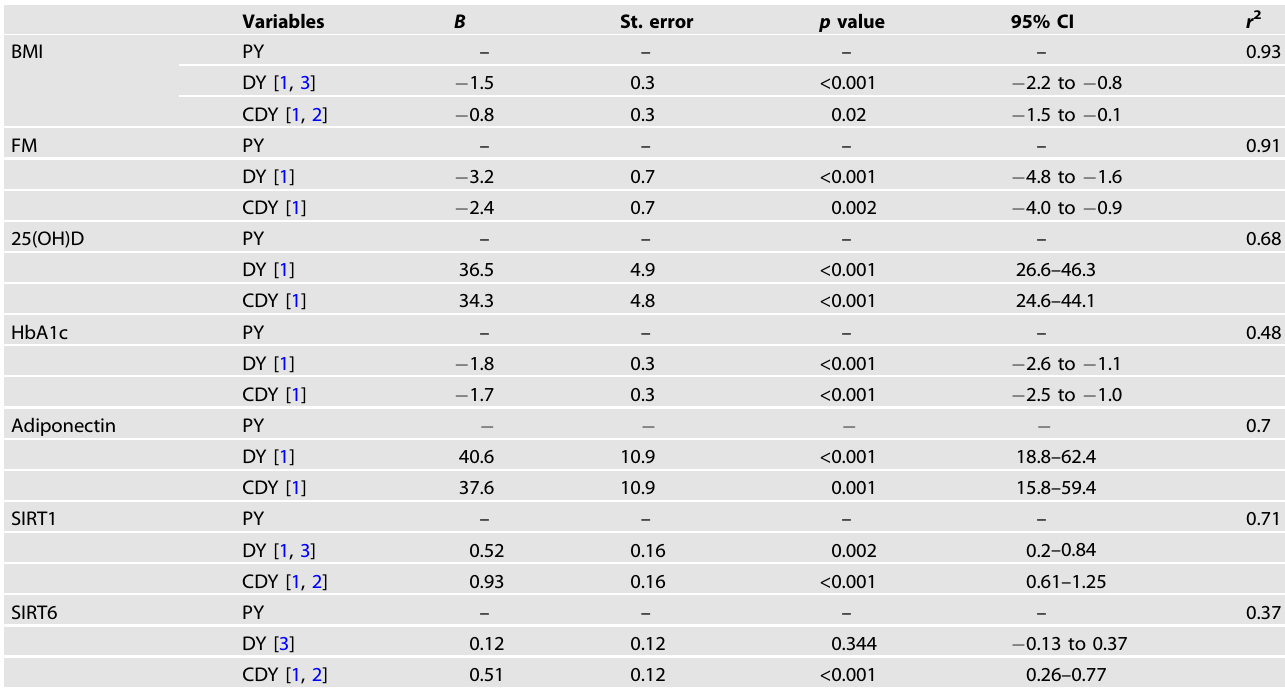
Table 4. Multiple regression results for variables after